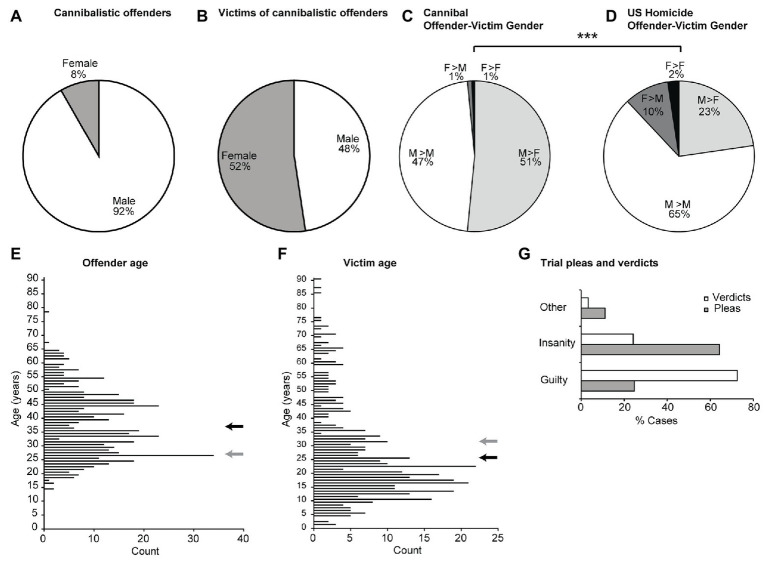
Gender and age of victims of cannibalistic homicides and of US homicides. (A) Gender of all cannibalistic offenders in this data set. (B) Gender of victims of all cannibalistic homicides in this data set. (C) Gender relationships in cannibalistic homicides. (D) Gender relationships in US homicides (Fox and Zawitz, 2010), which are different from the cannibalistic homicides in C [X
2(3) = 86.8, p < 0.001]. (E) Age of victims of all cannibalistic offenders in this data set. Black arrow indicates mean, gray arrow indicates mean age of US homicide offenders for comparison. (F) Age of victims of all cannibalistic homicides in this data set. Black arrow indicates mean, gray arrow indicates mean age of US homicide victims for comparison. (G) Pleas and verdicts in trials of all cannibalistic offenders.